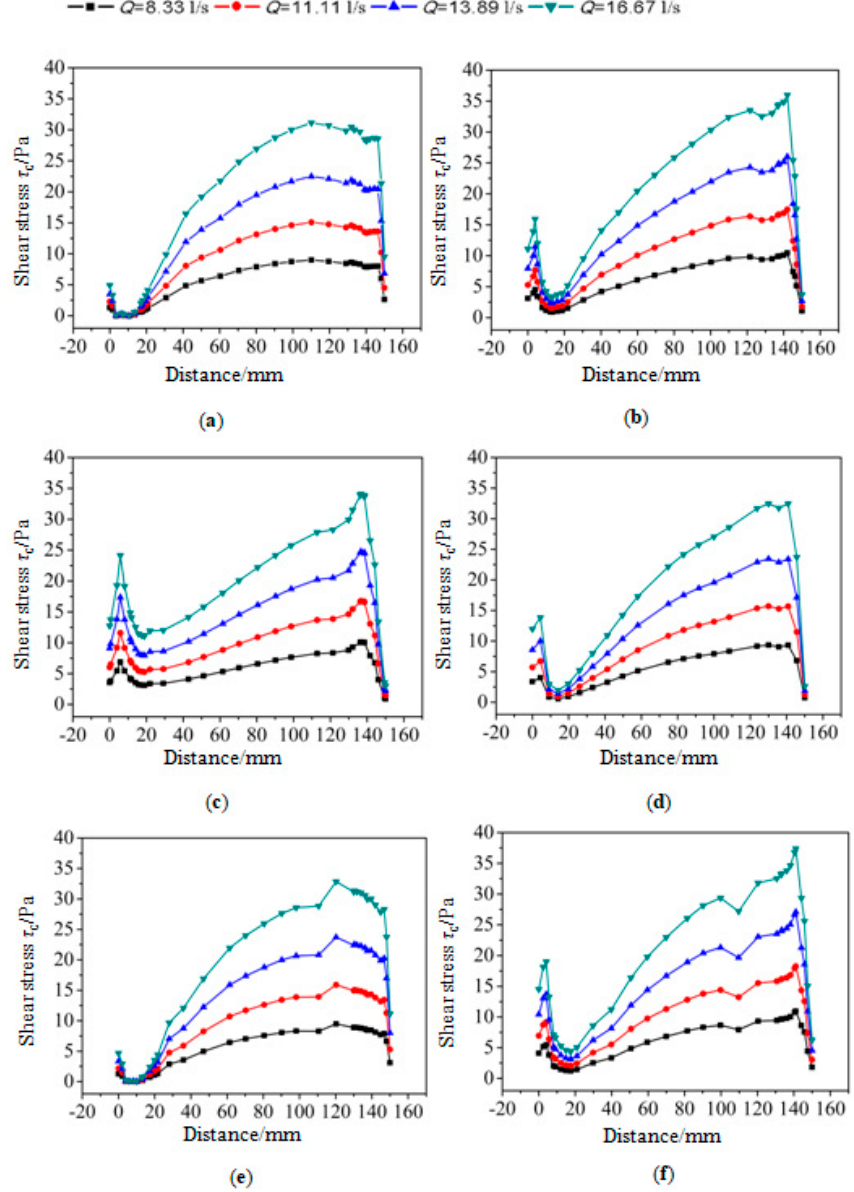
Figure 8. Capsule-wall shear stress with different discharge at same angle. ( a ) θ = 0°; ( b ) θ = 30°; ( c ) θ = 60°; ( d ) θ = 90°; ( e ) θ = 120°; ( f ) θ = 150°.